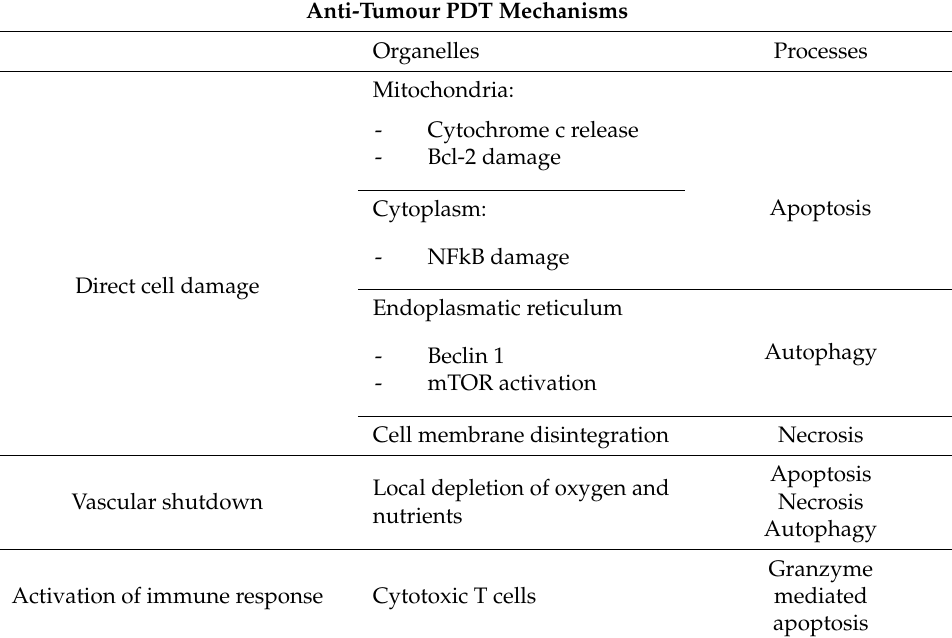
Table 3. Major cell death mechanism activated by PDT. Reproduced with permission from Pawel Mroz et al., Cancers; published by MDPI, 2011